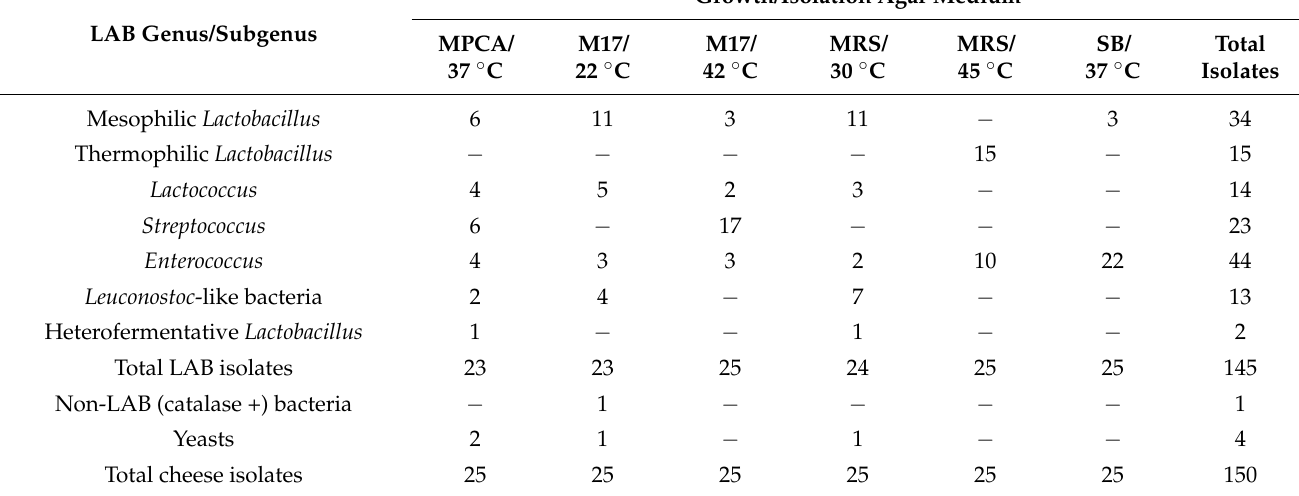
Table 3. Numerical distribution of the 145 LAB isolates from RTE Galotyri-like acid-curd cheese biochemically characterized at the genus/subgenus level and the remaining five non-LAB or yeast isolates in association with the selectivity of their enumeration/isolation agar